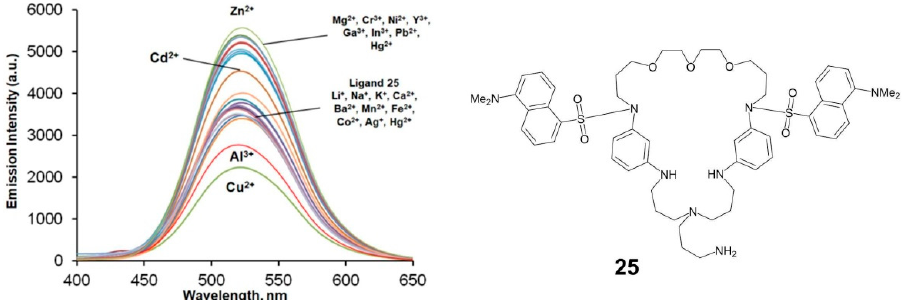
Figure 7. Spectra of the fluorescence of compound 25 in the presence of Li(I), Na(I), K(I), Mg(II), Ca(II), Ba(II), Al(III), Cr(III), Mn(II), Fe(II), Co(II), Ni(II), Cu(II), Zn(II), Cd(II), Hg(II), Pb(II), Ag(I), Ga(III), In(III) and Y(III) (five equiv.). C L 12.3 μ M, λ ex 340 nm.